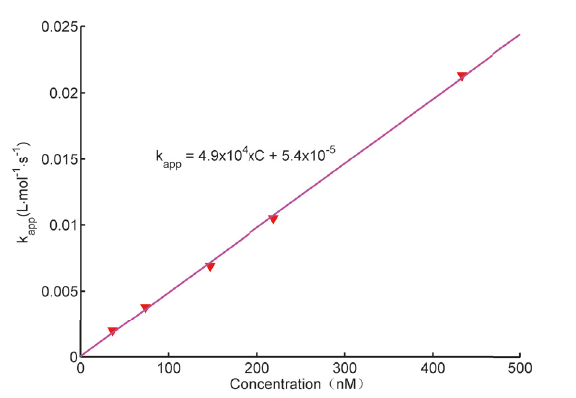
Figure 5: Association curve of biotin and avidin. Figure 6: k app versus different concentrations of